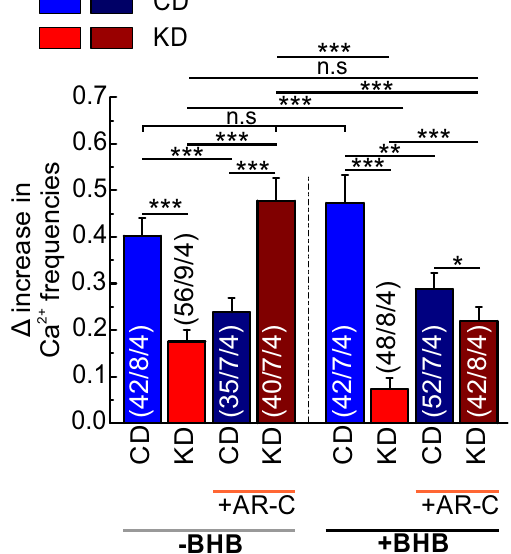
Figure 7. Net changes in the frequency of Ca 2 + transients elicited by 0 Mg 2 + /BIC in cortical slices from mice following control and ketogenic diets. Δ Ca 2 + of the frequency of the peaks occurred spontaneously and induced by 0 Mg 2 + /BIC in the absence (blue and red bars) and the presence (dark blue and wine red bars) of 1 µ M AR-C155858, in control and ketogenic cortical slices, respectively. Statistical values are presented as means ± S.E.M. Significance was tested with a paired Student’s t-test. Number of astrocytes/slices/mice used are indicated in the bar